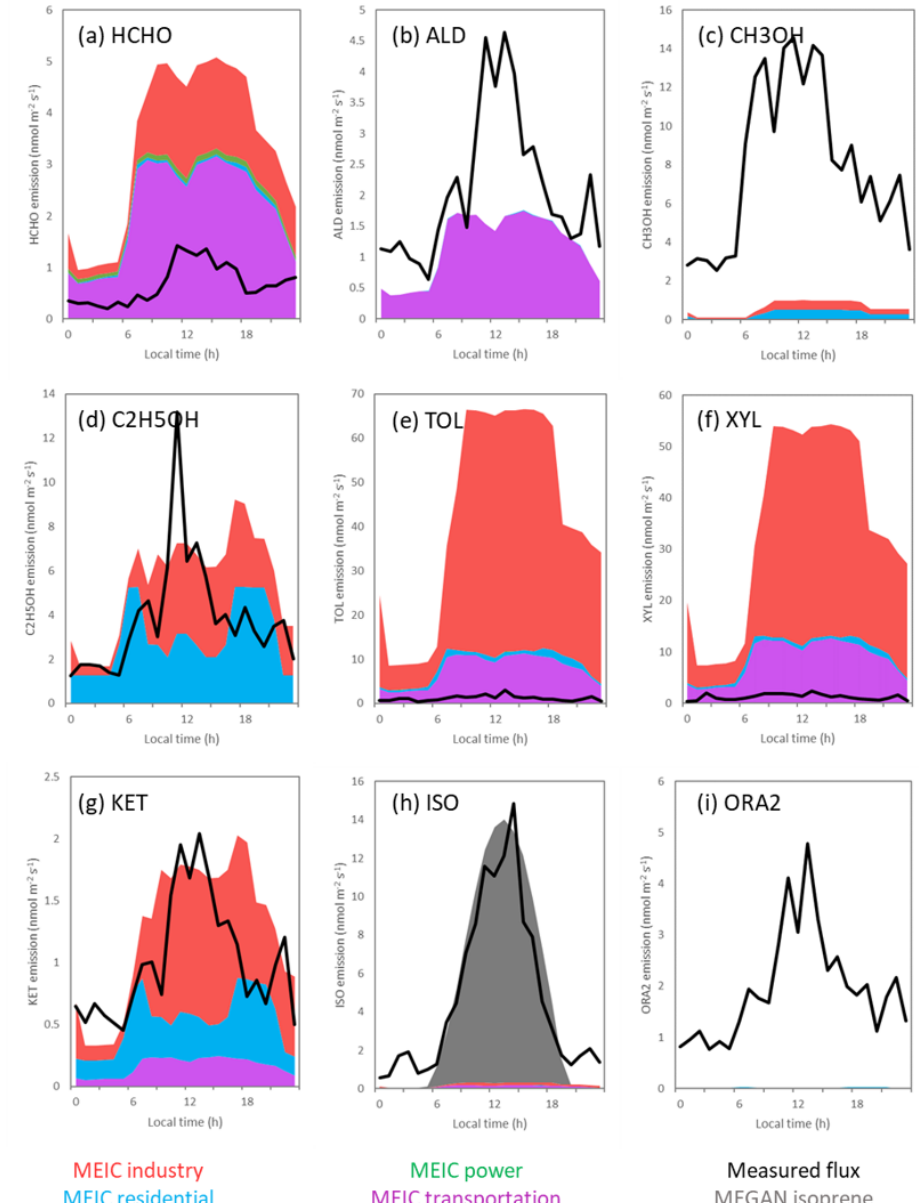
Figure 11. Comparison of nine VOC classes from the MEIC emissions inventory (Table 3) with the measured VOC flux (black line). The diurnal profiles of the isoprene emission predicted by MEGAN using the optimised emission factor are shown in grey (h)